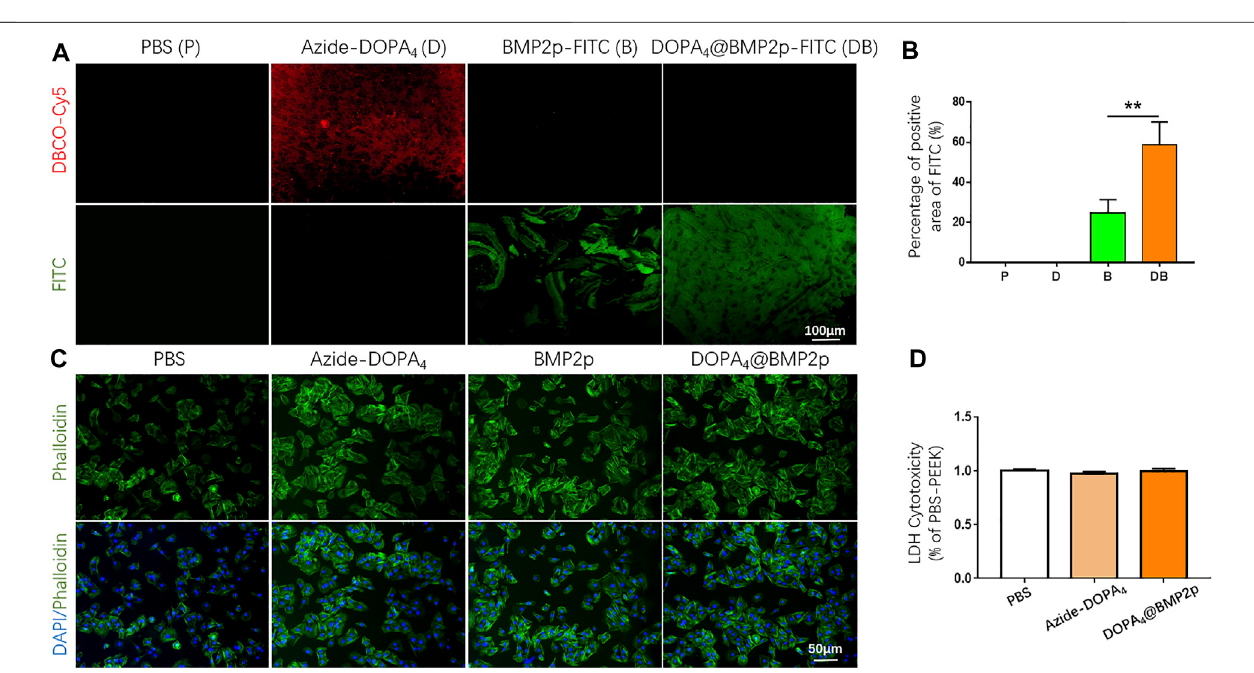
Frontiers in Bioengineering and Biotechnology |